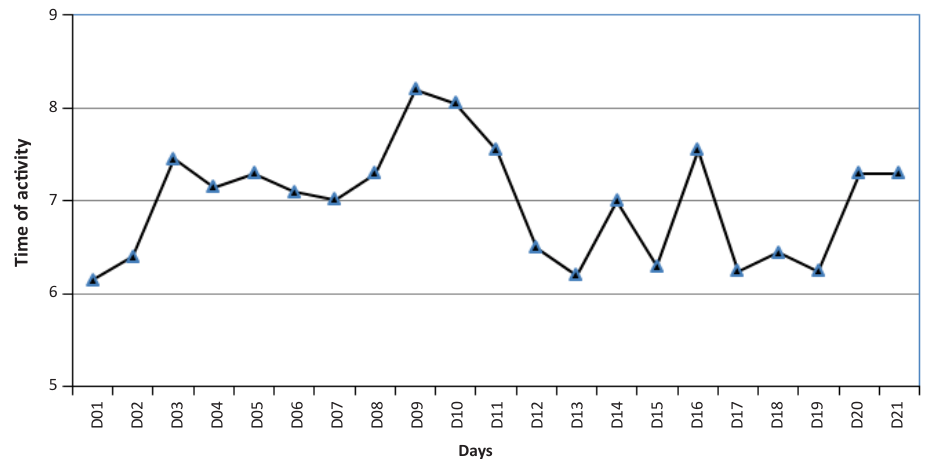
Figure 3. Emergence time of lizards from